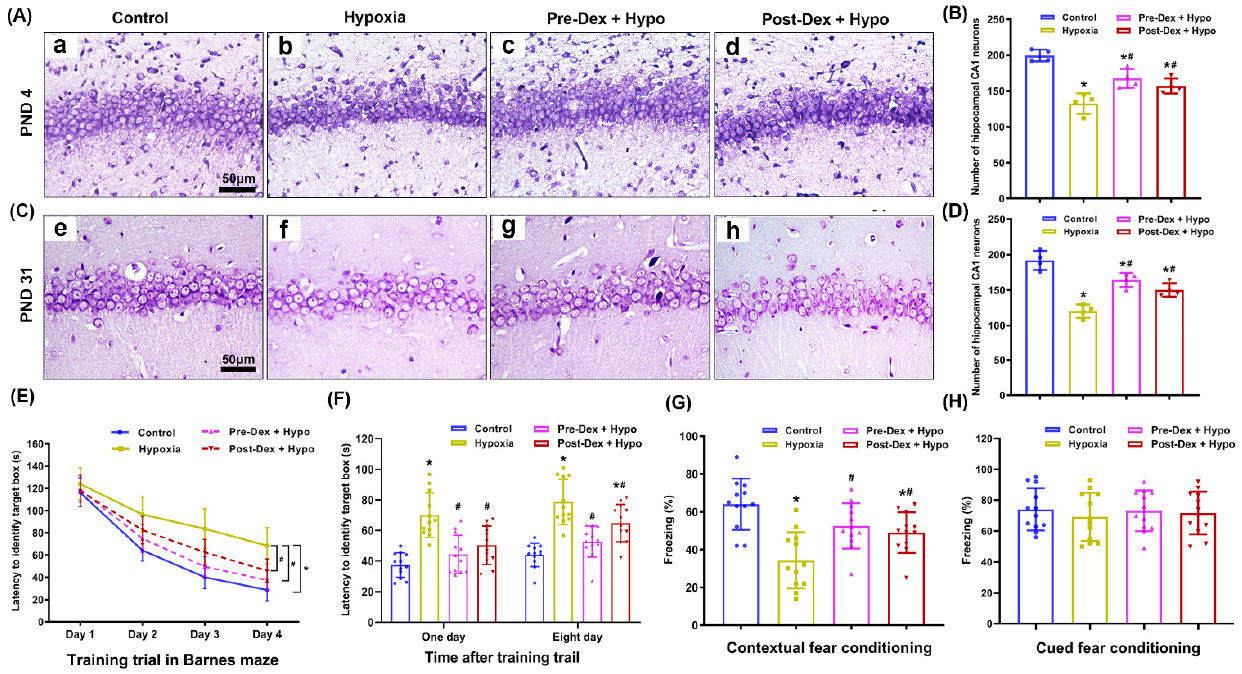
Figure 6. The effect of Dex on histopathological changes and cognitive function in the hippocampus following neonatal hypoxia. ( A , C ) Nissl staining was performed to evaluate hippocampal neuronal injury and morphological changes at 1 d (PND4) and 28 d (PND31) after neonatal hypoxia. ( B , D ) Quantification of the number of Nissl-positive cells present in the CA1 region of the hippocampus. ( E ) Performance with the Barnes maze test in training sessions. ( F ) Performance with the Barnes maze test in the memory phase. ( G ) Contextual fear conditioning test. ( H ) Cued fear conditioning test. Results are expressed as mean ± SD ( n = 4 in each group for Nissl staining data; n = 12 in each group for Barnes maze and fear conditioning test data). Each animal data point in the bar graph is also presented. * p < 0.05 versus the Control group; # p < 0.05 versus the Hypoxia group; & p < 0.05 versus the Pre-Dex group.